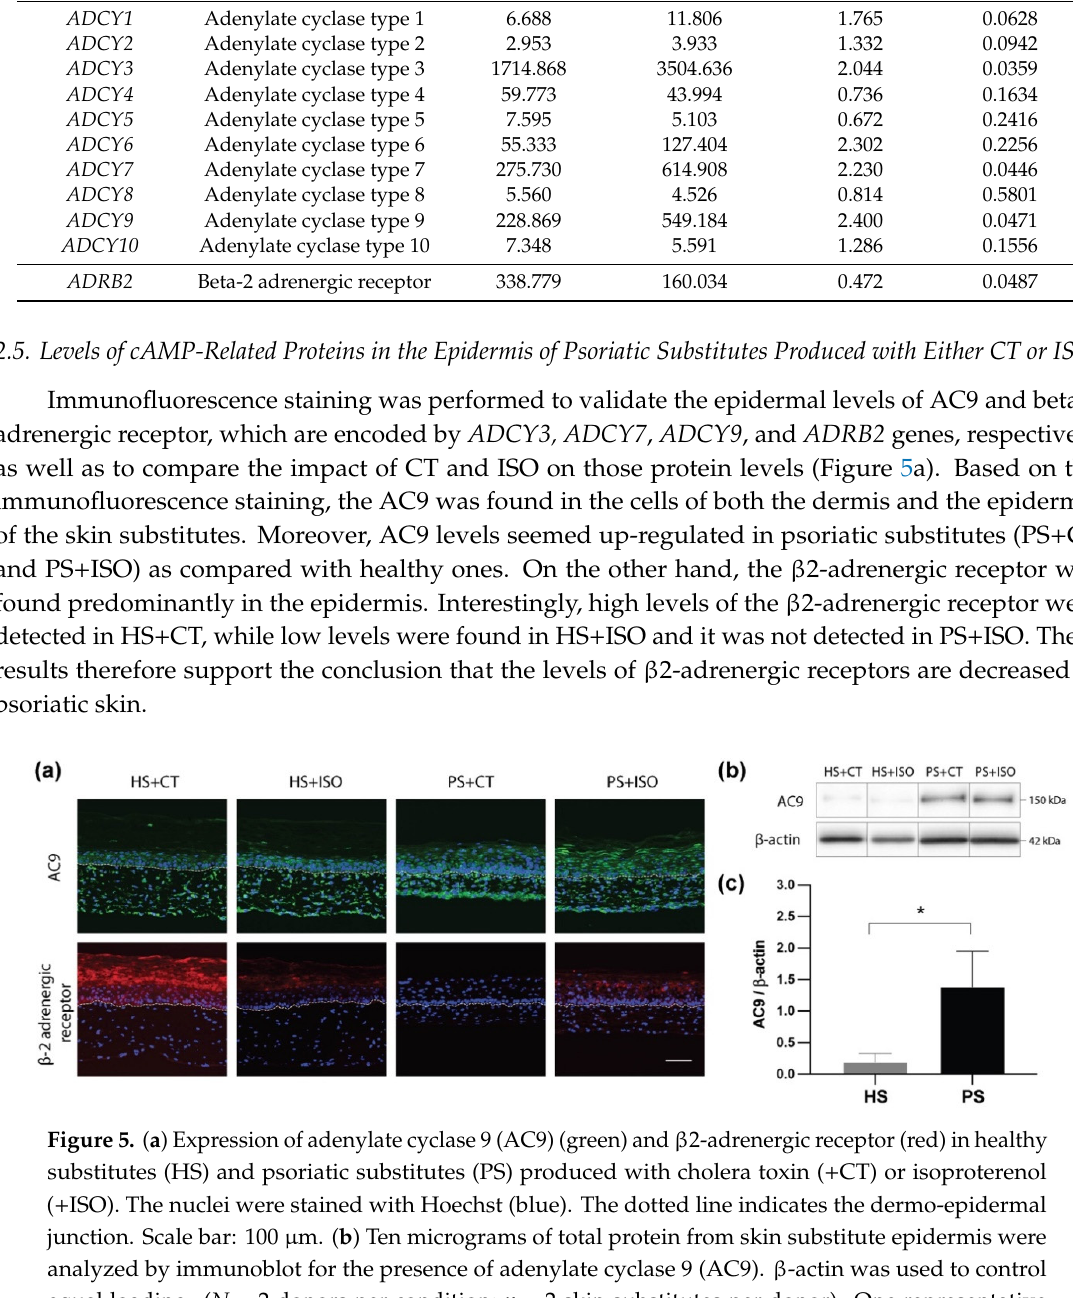
Table 1. Linear signals and fold change for ADCY1-10 and ADRB2 genes between healthy and psoriatic substitutes produced with CT.